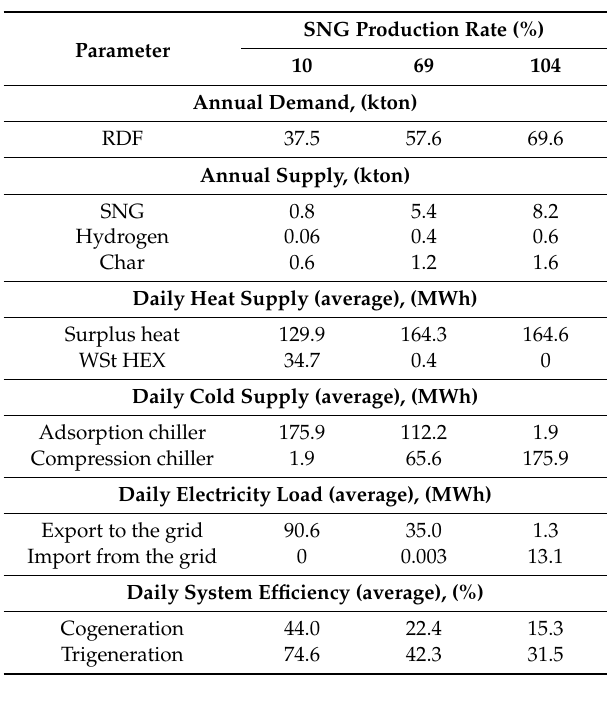
Table 4. Key system parameters for the different SNG production